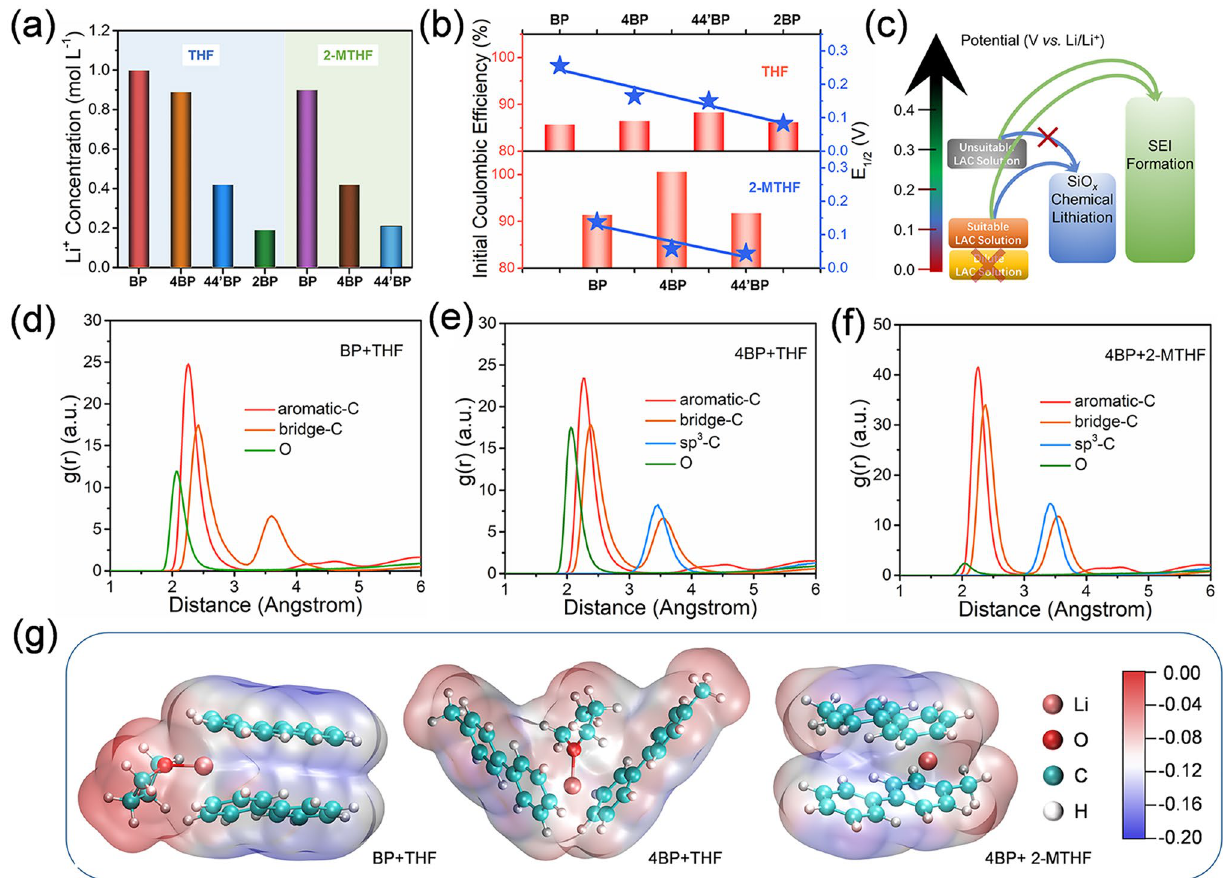
Fig. 3 a Li + concentrations of LAC reagents. b ICE and E 1/2 of p-SiO/C anodes. c Schematic diagram of the relationship between LAC reagent and prelithiation efficiency of SiO/C anode. d, f Calculated radial distribution functions and g the corresponding first solvation sheath structures with electrostatic potential mappings of different LAC